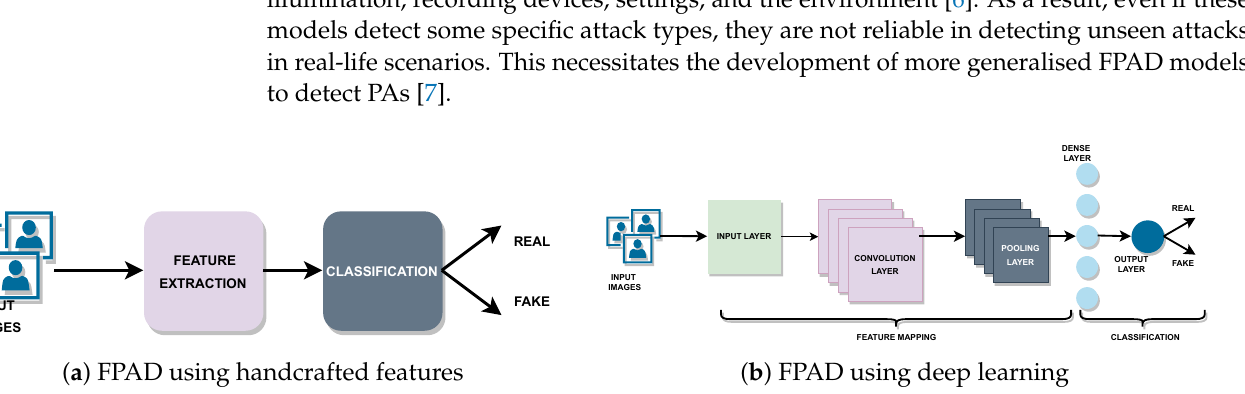
Figure 1. Face presentation attack detection (FPAD) methods: ( a ) The hand-crafted feature method has a feature-extraction module followed by a classifier. Manual feature extraction is carried out in this FPAD method. ( b ) In deep learning-based FPAD, extracted features are passed to the classifier following an end-to-end learning method. Unlike hand-crafted feature methods, CNNs facilitate automatic feature extraction in deep learning based